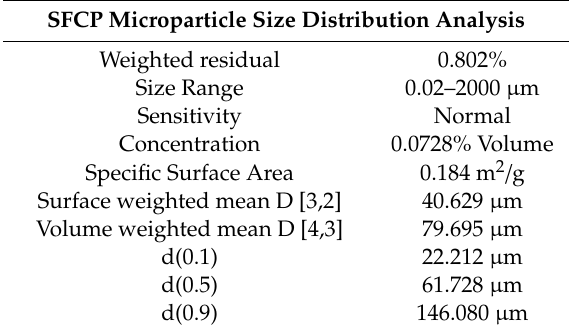
Table 1. Particle size distribution results of Mastersizer analysis.